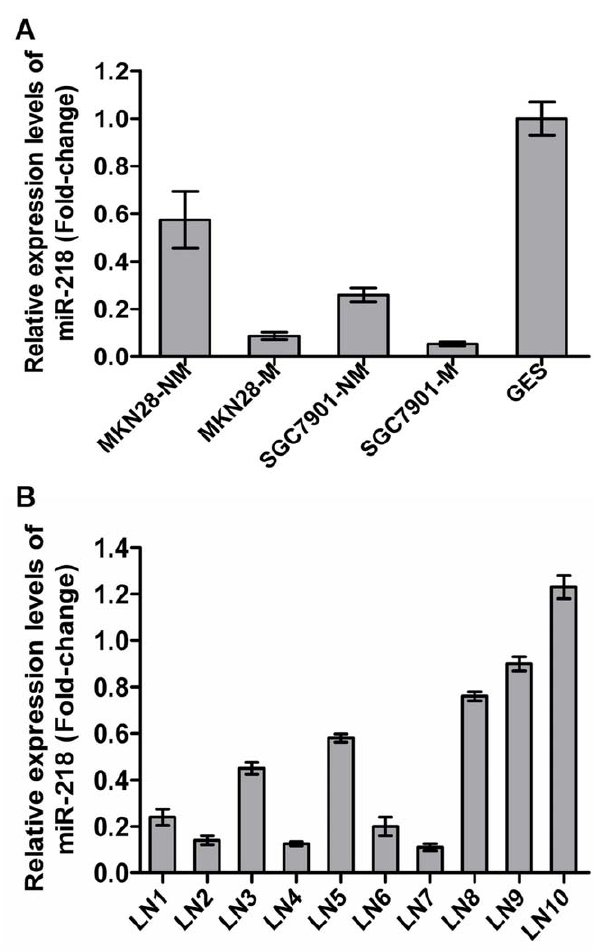
Figure 2. Validation of miR-218 expression in metastatic GC cells. The expression of miR-218 was investigated by qRT-PCR. (A) Each bar represents the relative fold change compared to GES cell lines. (B) Bars represent relative fold changes between primary GC and metastatic lymph nodes from the same patient. Each sample was analyzed in triplicate and was normalized to U6. Fold change was calculated by 2 2 DD Ct . The results were consistent with the microarray data.